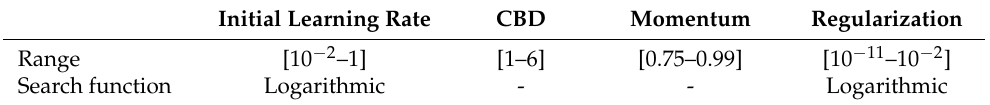
Table 1. Optimization variables ranges and search functions used during the optimization